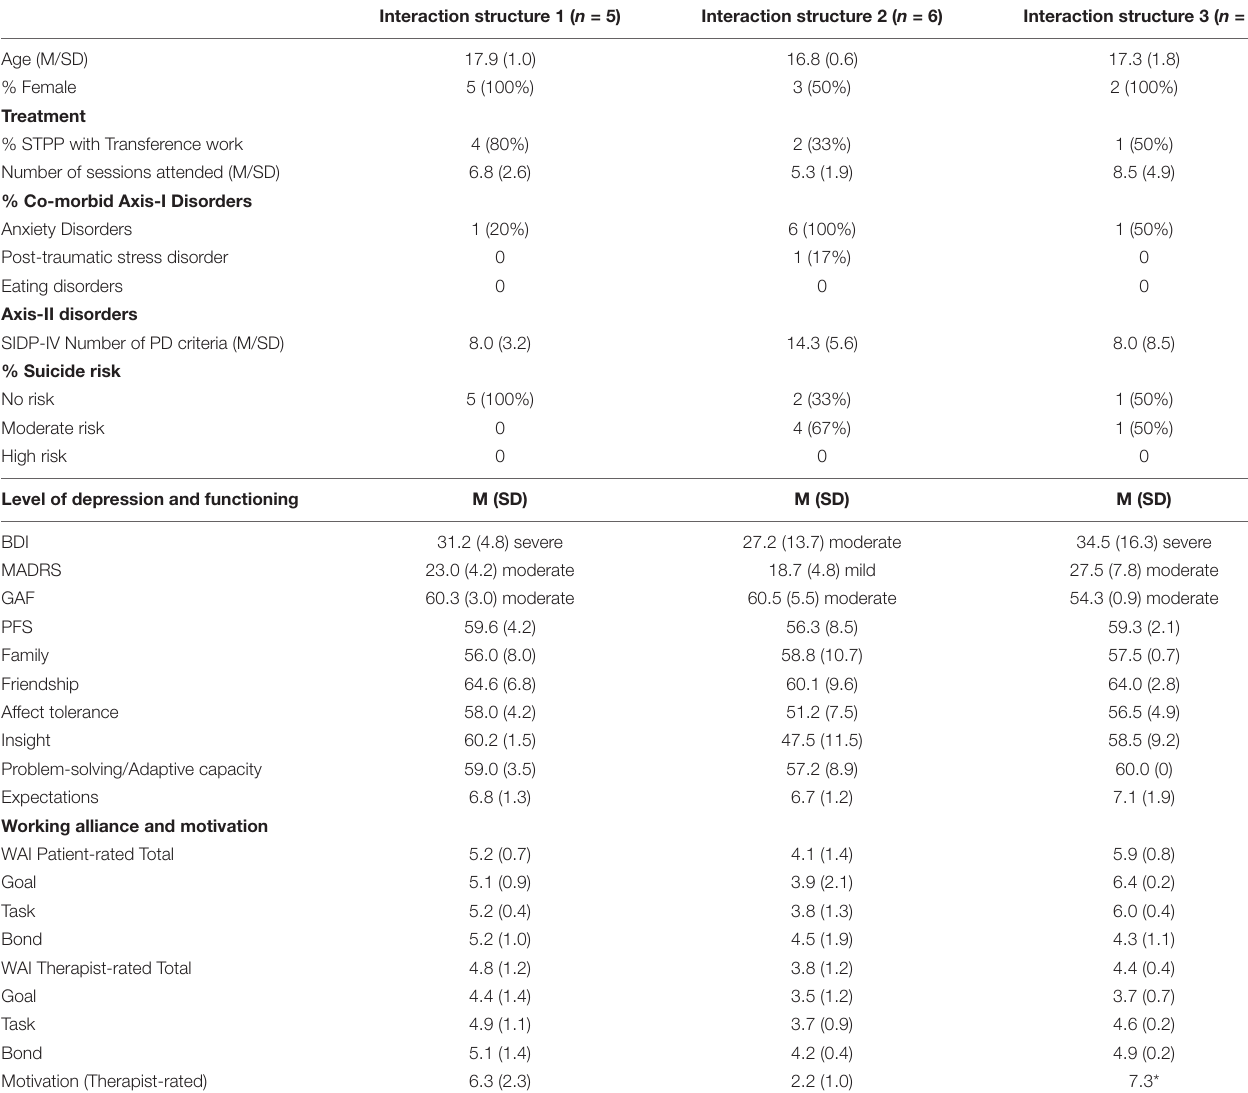
TABLE 6 | Comparison of the three interaction structures in terms of patient and clinical characteristics, and working alliance in session